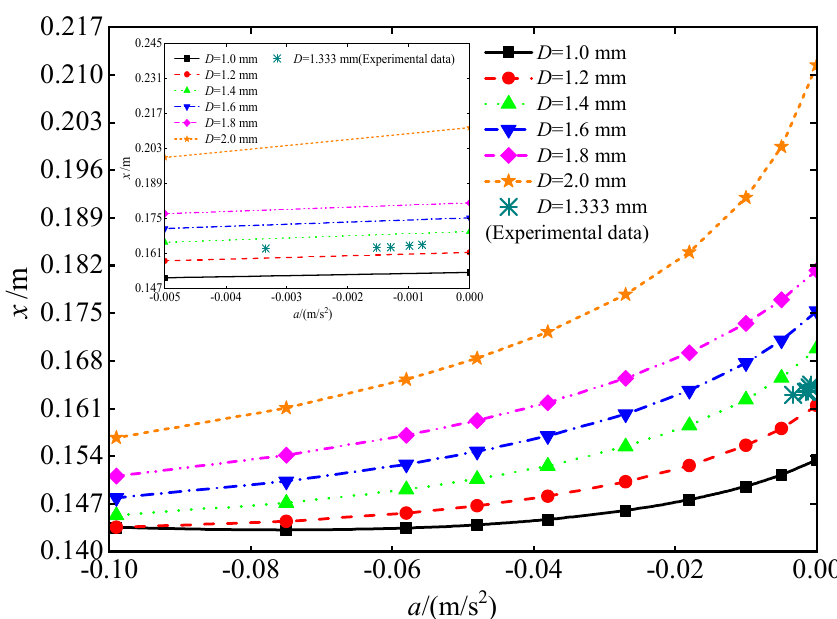
Figure 15. Relationship between the travel distance and velocity skewness of sediment particles.